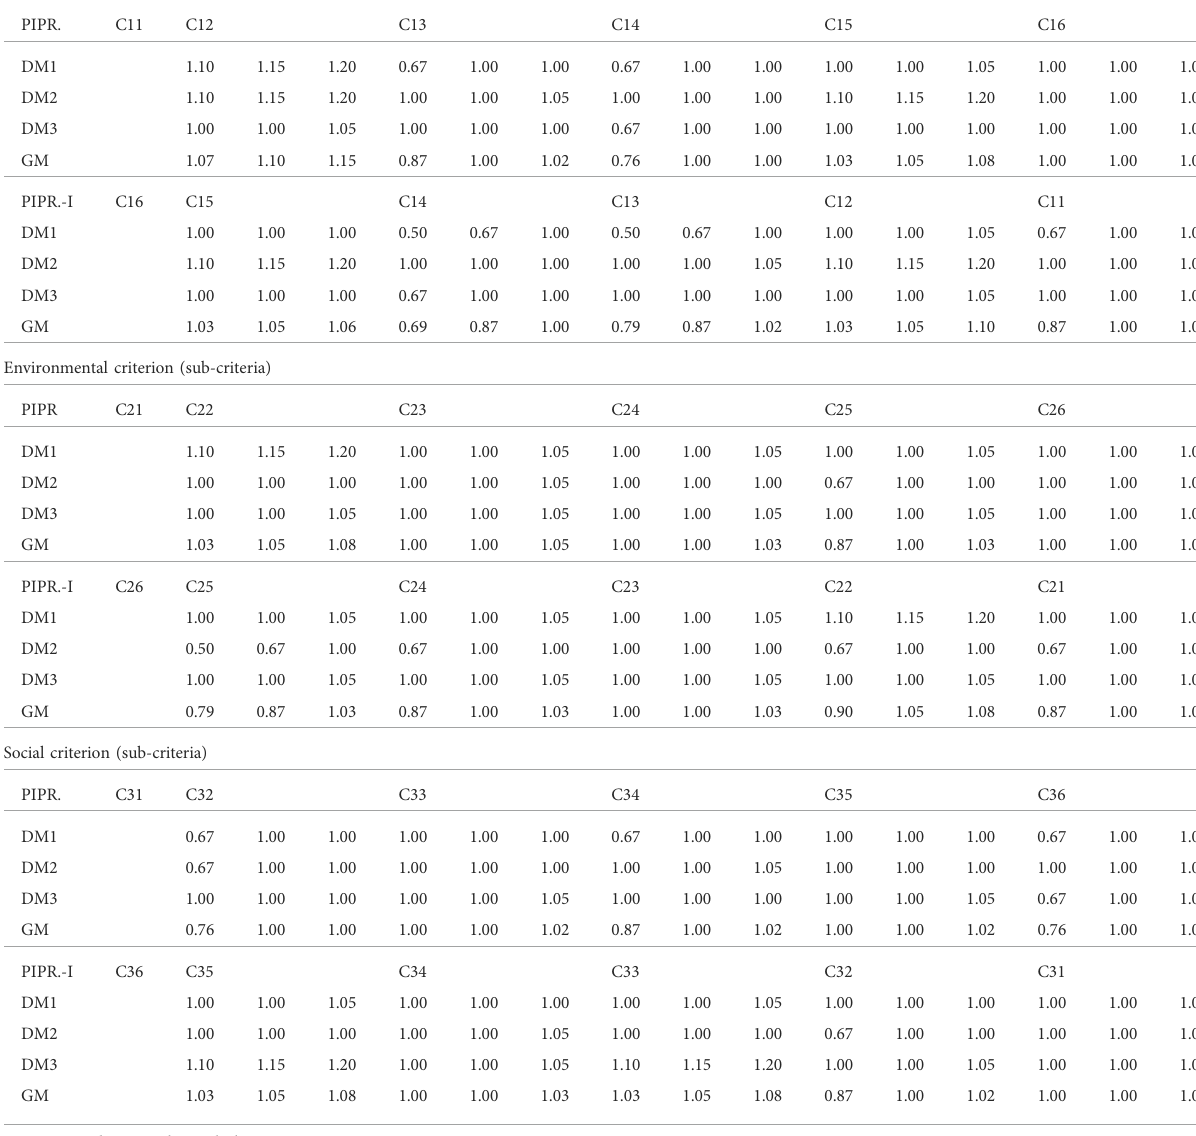
TABLE 5 Evaluation of sub-criteria by fuzzy PIPRECIA method.